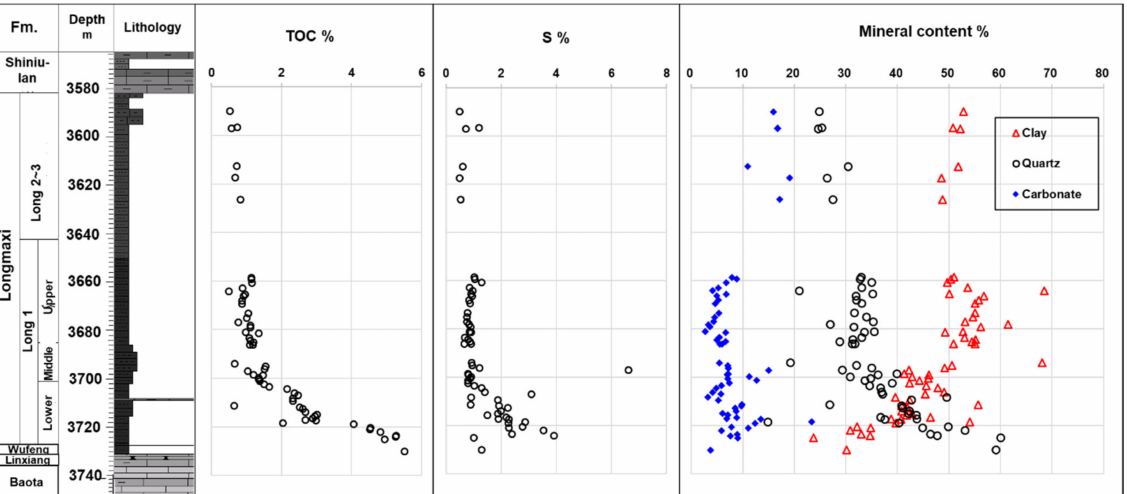
Figure 2. The geological column, TOC and sulfur contents, and main mineral compositions of samples from Well A in the Dingshan area, Sichuan